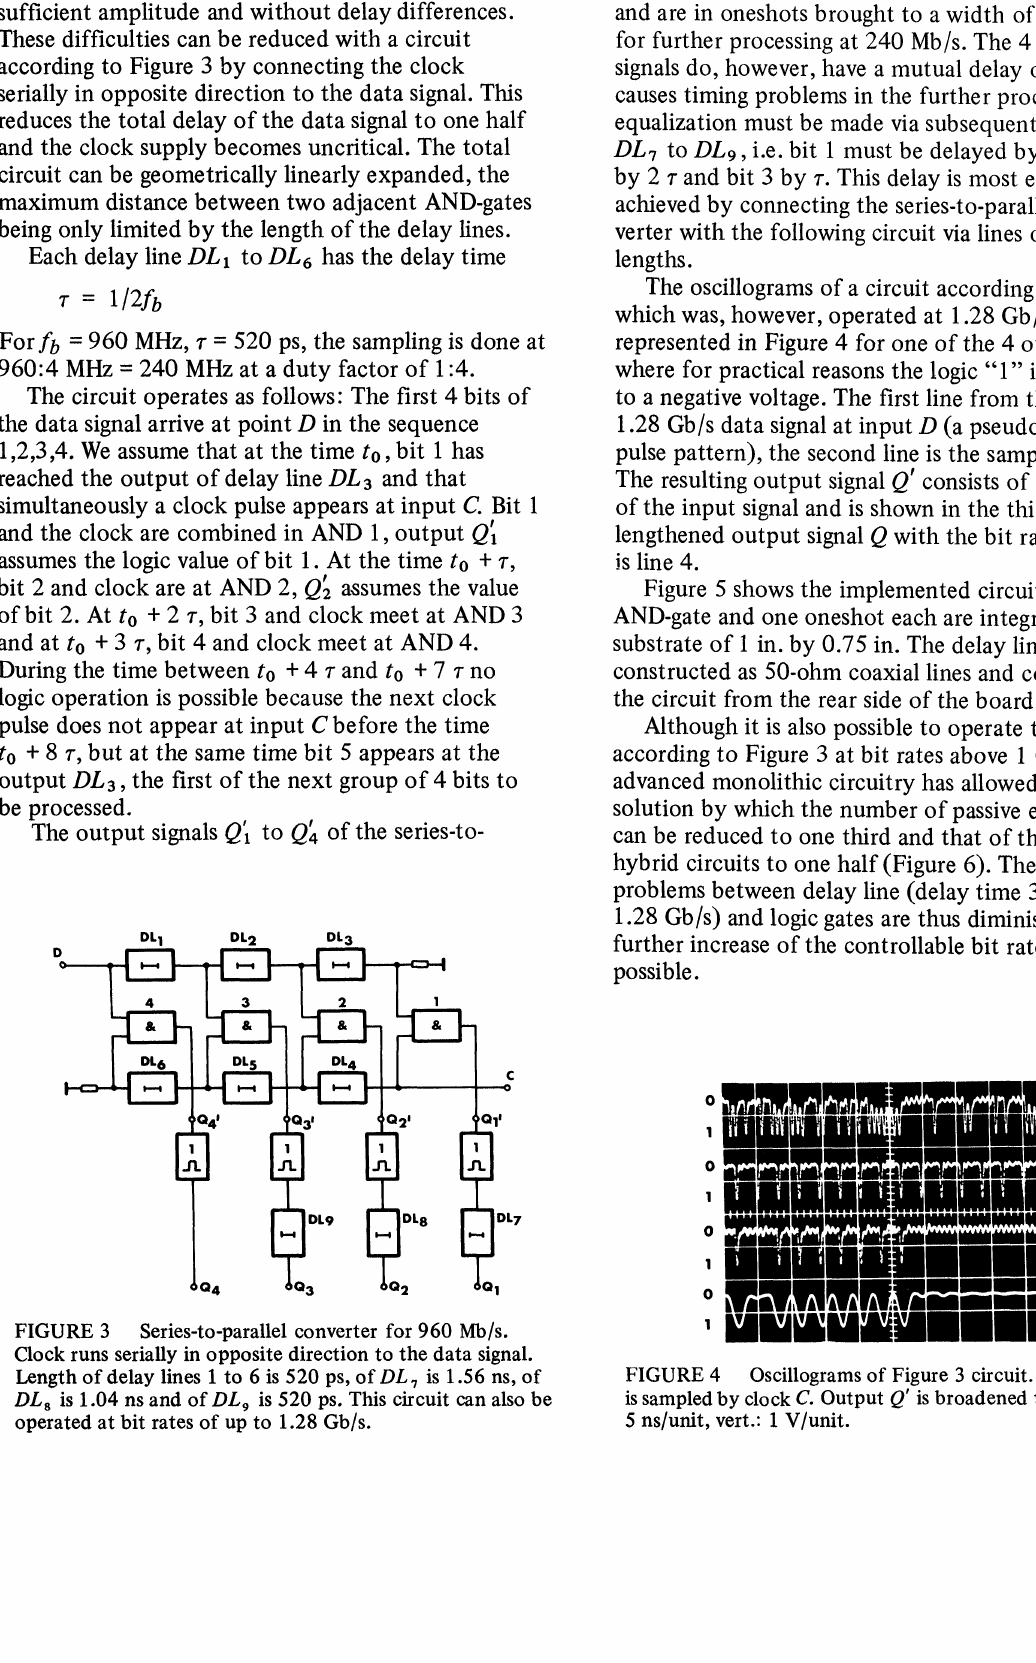
Series-to-parallel converter for 960 Mb[s. Clock runs serially in opposite direction to the data signal. Length of delay lines 1 to 6 is 520 ps, of DL. is 1.56 ns, of DL8 is 1.04 ns and of DL is 520 ps. This circuit can also be operated at bit rates of up to 1.28 Gb/s.